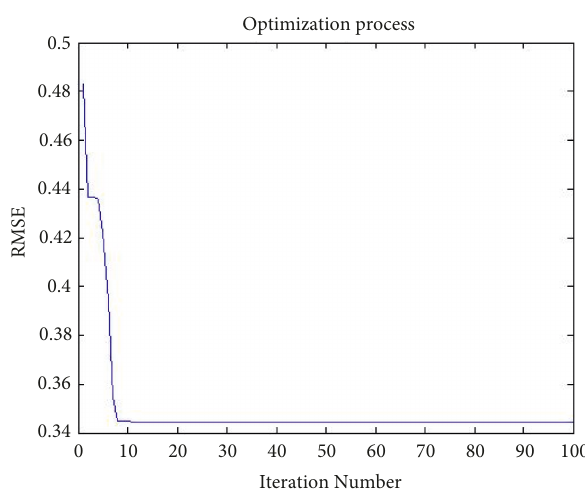
Figure 6: IFOA-GRNN convergence graph.